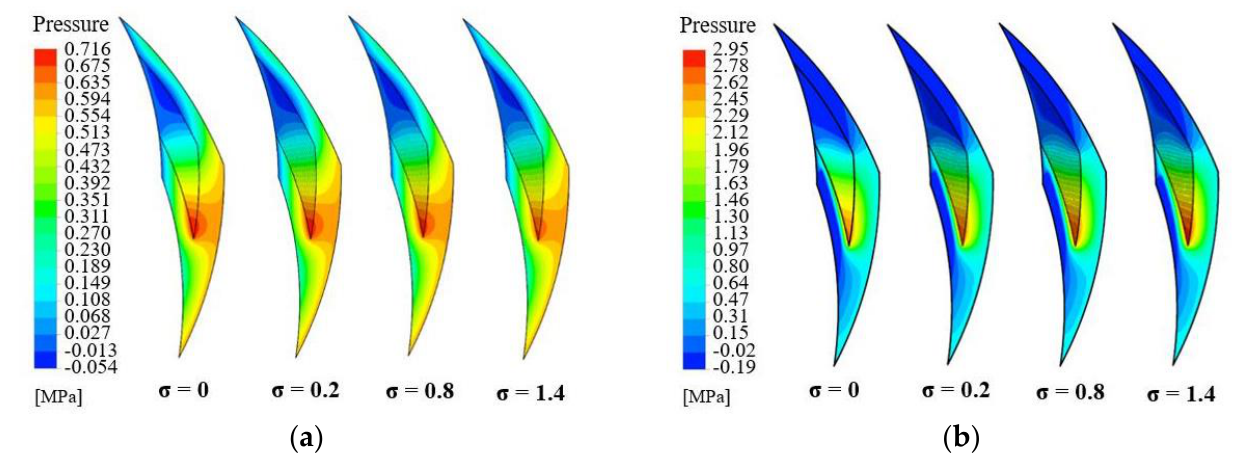
Figure 11. Pressure distribution under different roughness values in the grooved zone of the rotating ring: ( a ) n = 1000 rpm, ( b ) n = 10,000 rpm.